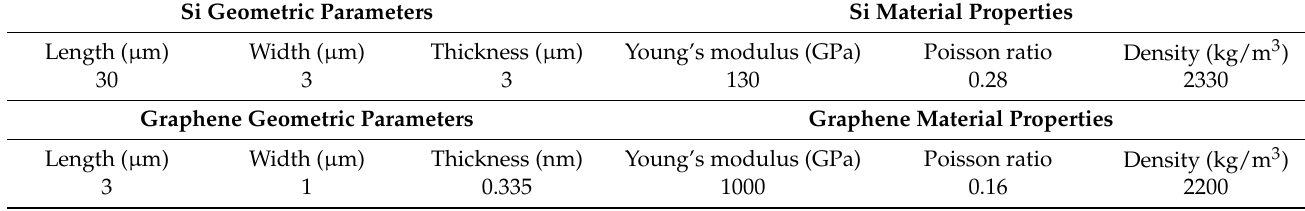
Table 1. Initial parameters and material properties of silicon and graphene resonant beams. Si Geometric Parameters